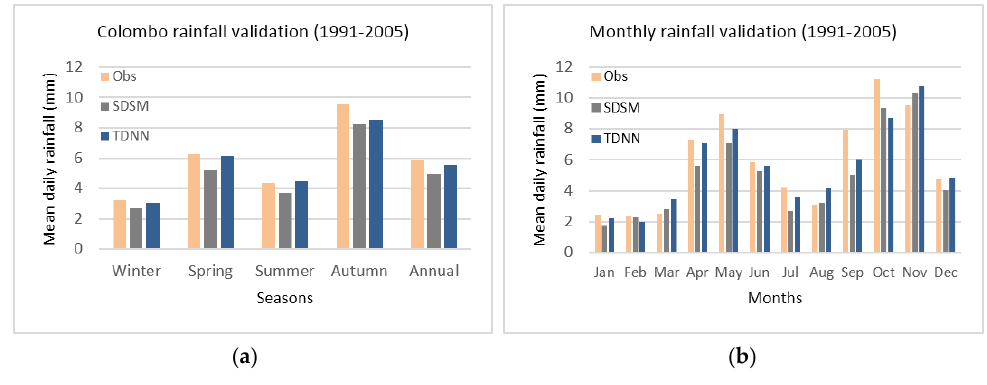
Figure 4. Rainfall validation ( a ) seasonal; ( b ) monthly.